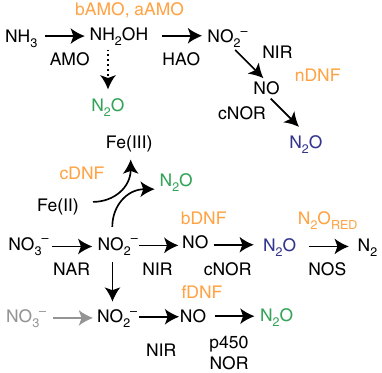
Figure 1 | Schematic representation of N 2 O production pathways considered in this study. N 2 O can form during decomposition/reaction of intermediate hydroxylamine (NH 2 OH) produced during ammonia oxidation by bacteria (bAMO) or archaea (aAMO). Some of these nitrifying organisms may also produce N 2 O during reduction of product nitrite (NO 2 (cid:2) ), known as nitrifier-denitrification (nDNF). N 2 O may also be produced during reduction of nitrate and/or nitrite by denitrification catalysed by bacteria (bDNF), fungi (fDNF) and/or by chemical reaction with Fe(II) or ‘chemodenitrification’ (cDNF). Finally, N 2 O can also be reductively consumed by denitrifying bacteria (N 2 O RED ). N 2 O produced having low or negative site preference values ( (cid:2) 10 to 0 % ) are indicated in blue, while those have high site preference values ( 4 15 % ) are indicated in green. Enzymes are indicated as ammonia monooxygenase (AMO), hydroxylamine oxidoreductase in bacterial nitrification (HAO), nitrate reductase (NAR), nitrite reductase (NIR), bacterial nitric oxide reductase (cNOR), nitrous oxide reductase (NOS) and fungal nitric oxide reductase (p450NOR). The detailed biochemical pathway of nitrite production by archaeal ammonia oxidation remains